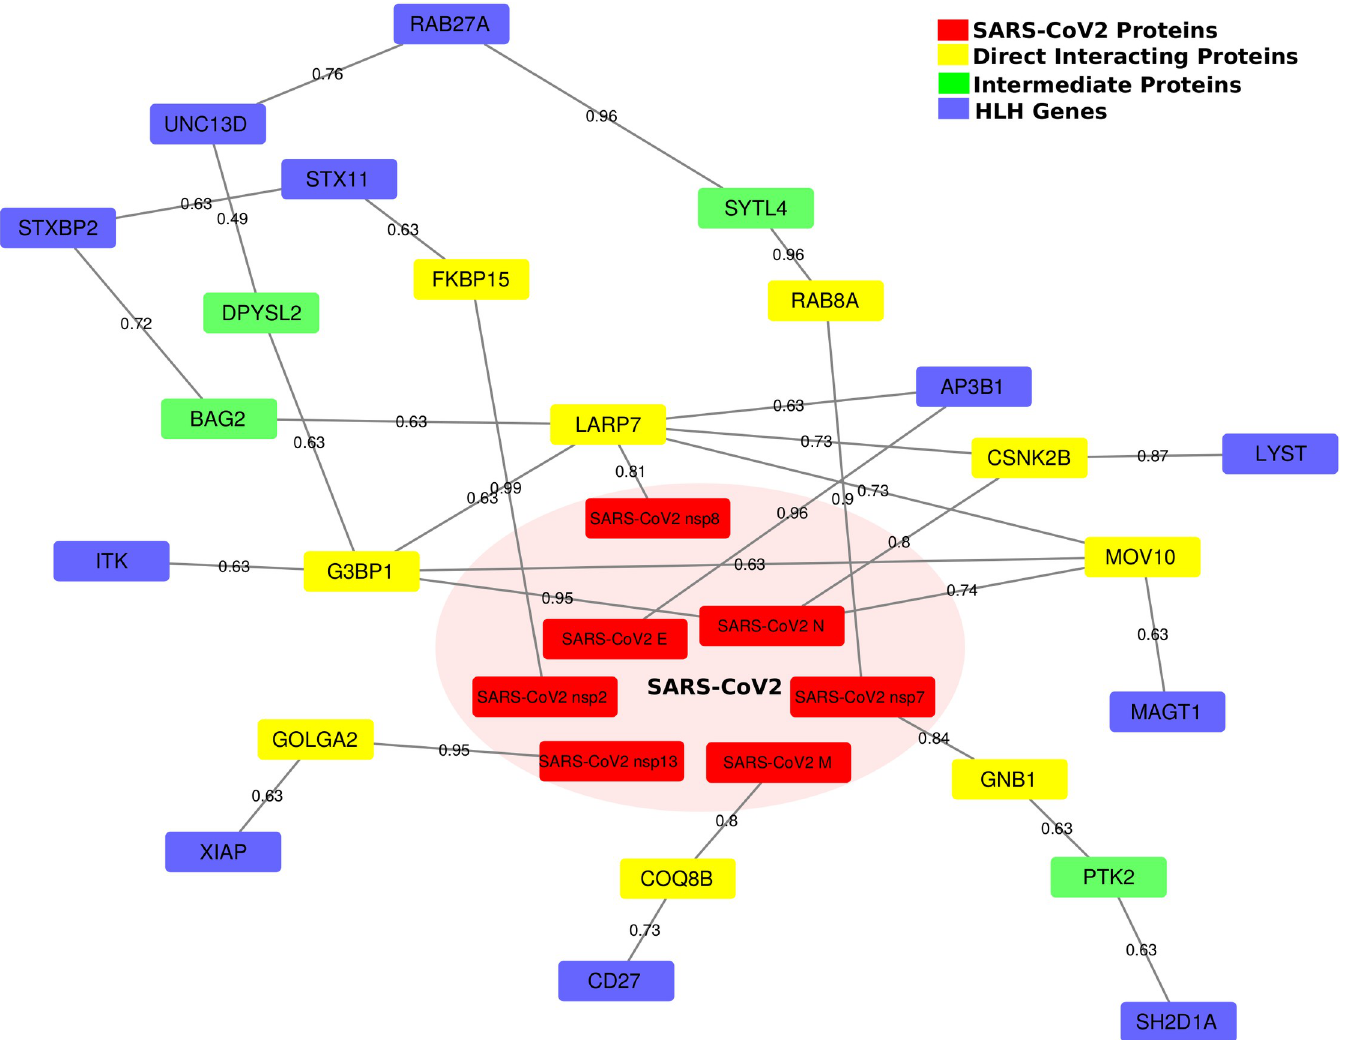
Fig 1. Reconstructed network paths from SARS-CoV-2 proteins to HLH genes. This network shows all the paths connecting the SARS-CoV-2 proteins to the HLH proteins (genes). The red nodes represent the SARS-CoV-2 proteins, the yellow nodes are the human host proteins that directly interact with SARS-CoV-2 proteins, the green nodes are the intermediate interacting host proteins, and the blue nodes denote the target HLH proteins (genes). The edge weights in the network represent the interaction strength (or probability).